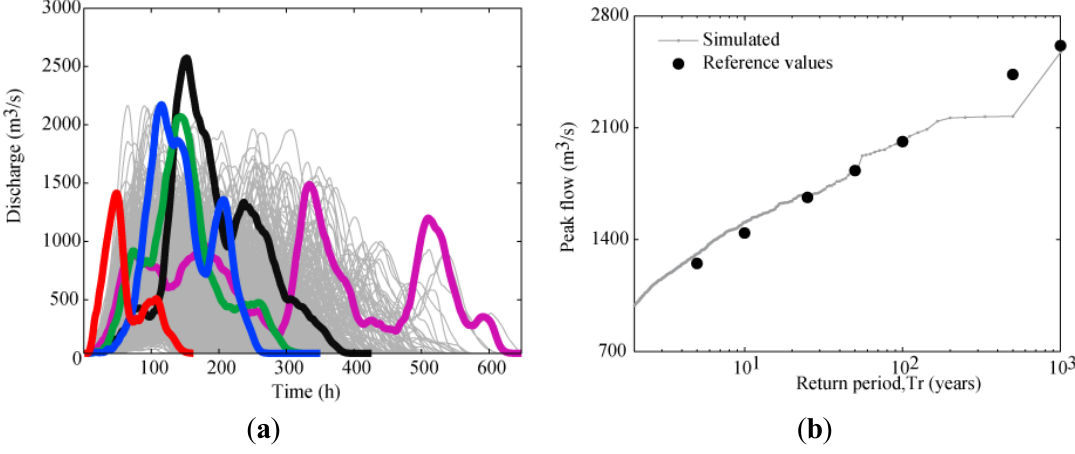
Figure 7. Ensemble of flood hydrographs. ( a ) Stochastically generated flood events (selected hydrographs are highlighted to visualize the variety of shapes and duration); and ( b ) Calibration of the flood peak frequency curve.